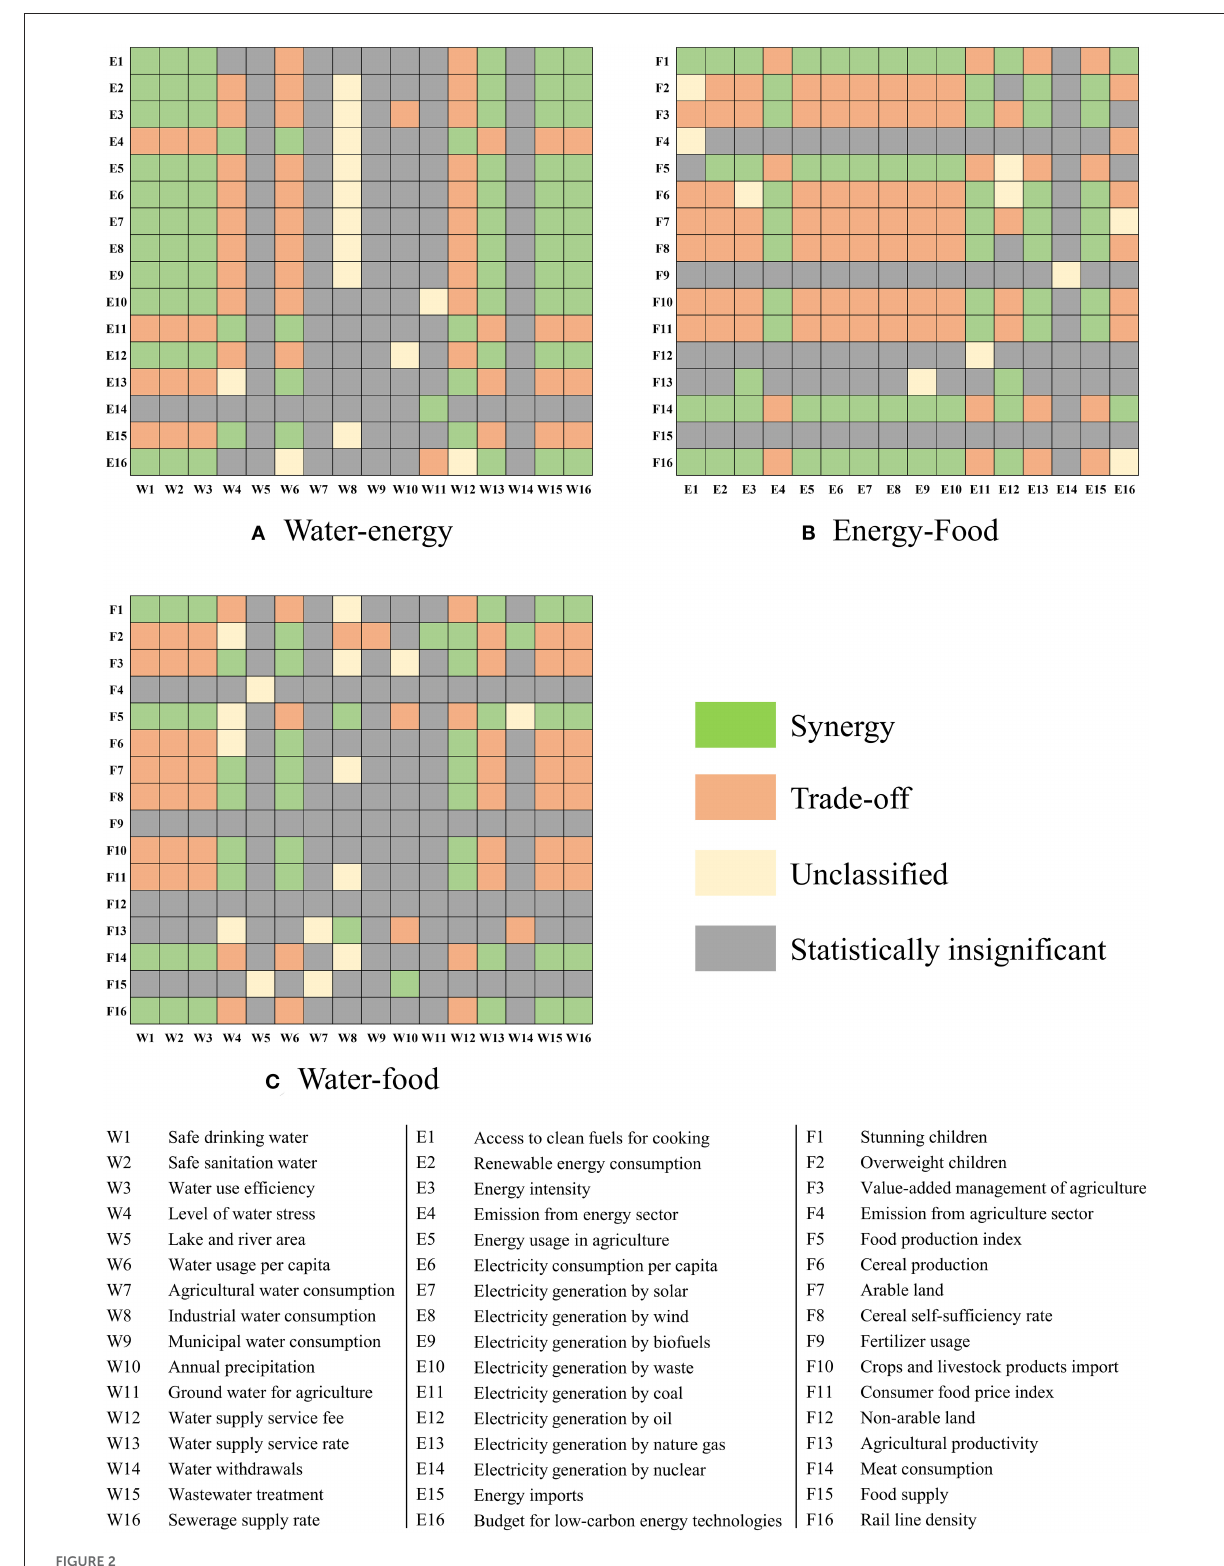
FIGURE2 Interactions among water, energy, and food (WEF) security indicators in South Korea: (A) Interactions among water-energy security indicators, (B) interactions among energy-food security indicators, and (C) interactions among water-food security